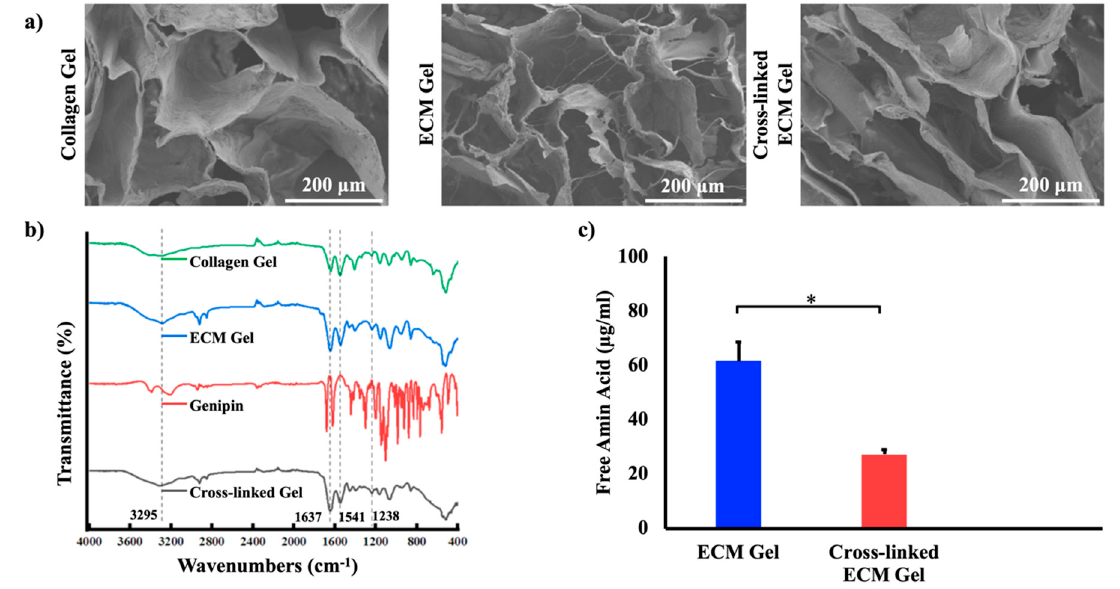
Figure 3. ( a ) Representative SEM images of the collagen, ECM, and cross-linked ECM gels; ( b ) Fourier-transform infrared (FTIR) analysis; ( c ) free amino acid determination using ninhydrin assay ( n = 3), showing a significant decrease of free amino acid amount in cross-linked ECM gel (* p < 0.05).